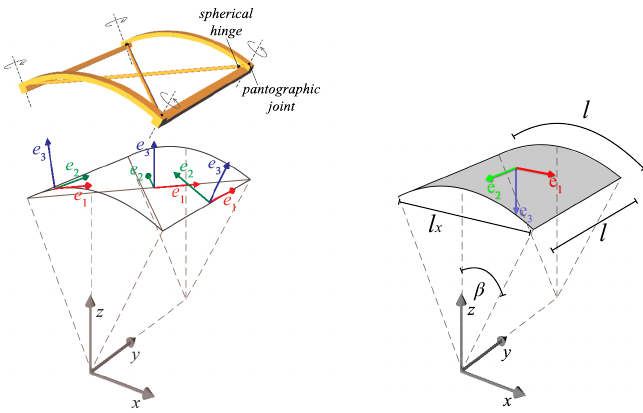
Figure 1. ( Left ) The fine geometry of the REV, together with local and global axes. The rotation axes for pantographic joints are shown. ( Right ) The corresponding continuum region, together with local, global axes and